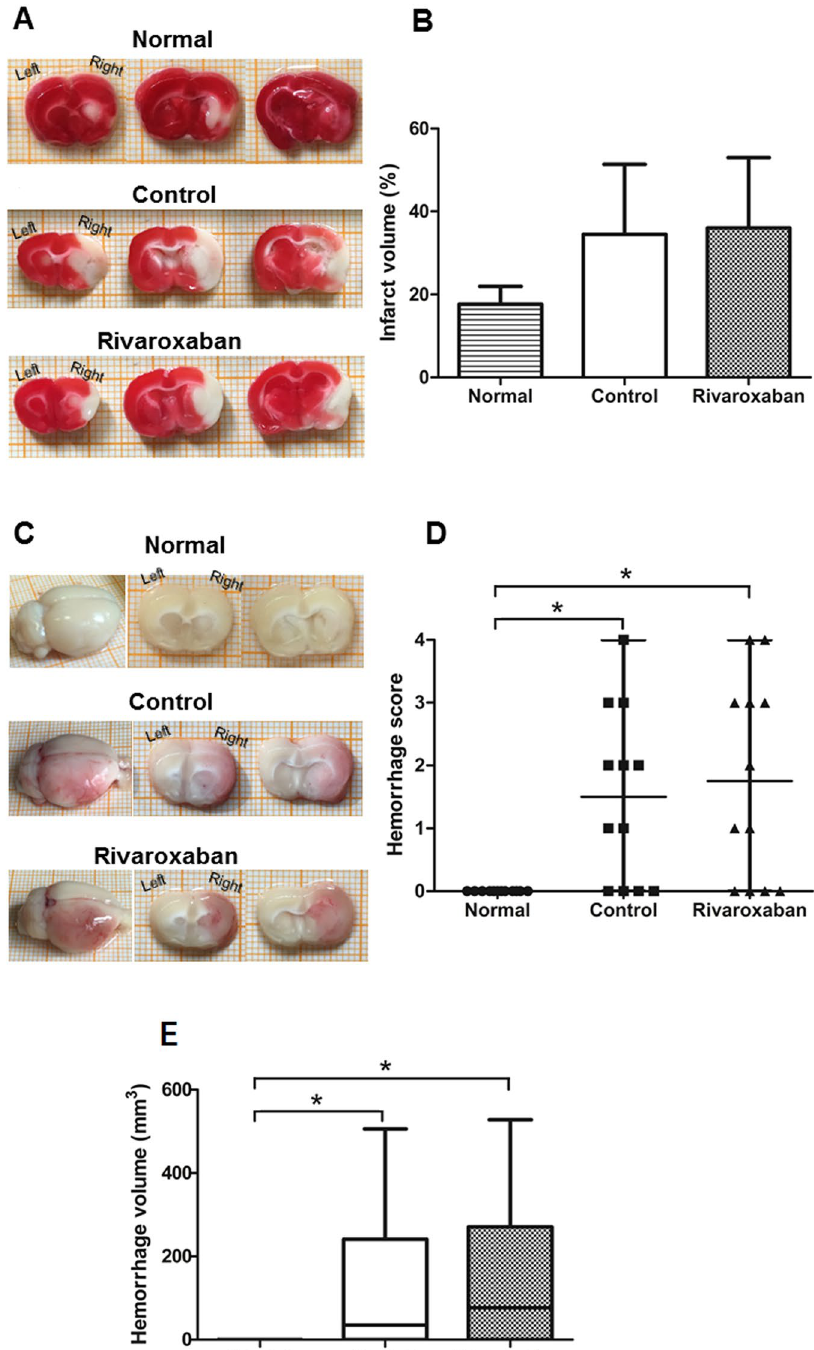
Figure 3. Diabetic rats show increased infarct volume and HT post-ET than normal rats; Rivaroxaban does not increase infarct volumes and HT scores in diabetic rats post-ET. ( A ) Representative images showing 2,3,5-triphenyltetrazoliumchloride (TTC) staining for infarct volume in normal rats (n = 6), diabetic control rats (n = 6) and Rivaroxaban-pretreated rats (n = 6). ( B ) Bar graph depicting infarct volume in all the groups. Ischemic lesion size of the normal group is 17.67 ± 1.76%, the diabetic control group is 34.48 ± 6.90% and the Rivaroxaban group is 36.04 ± 6.92% 24 h after 1 h tMCAO (one-way ANOVA, P = 0.07). ( C ) Representative images showing visible hemorrhage in normal (n = 12), diabetic control (n = 12) and Rivaroxaban-pretreated rats (n = 12). ( D ) Macroscopic hemorrhage scored by a masked rater. Individual scores and bars indicate median and range. HT score of normal group, diabetic control group, and Rivaroxaban group is 0 (IQR: 0–0), 1.5 (IQR: 0–2.75), and 1.5 (IQR: 0–3), respectively, at 24 h post-ET surgery. Both the Control and Rivaroxaban groups have higher HT score than the Normal group ( * P < 0.05), while the Control and Rivaroxaban group have similar HT score ( P = 1.00) (Kruskal-Wallis ANOVA and a Dunn-Bonferroni test for post hoc comparisons). ( E ) Box-plot depicting HT volume of rats in all the groups. Median of HT volume of the